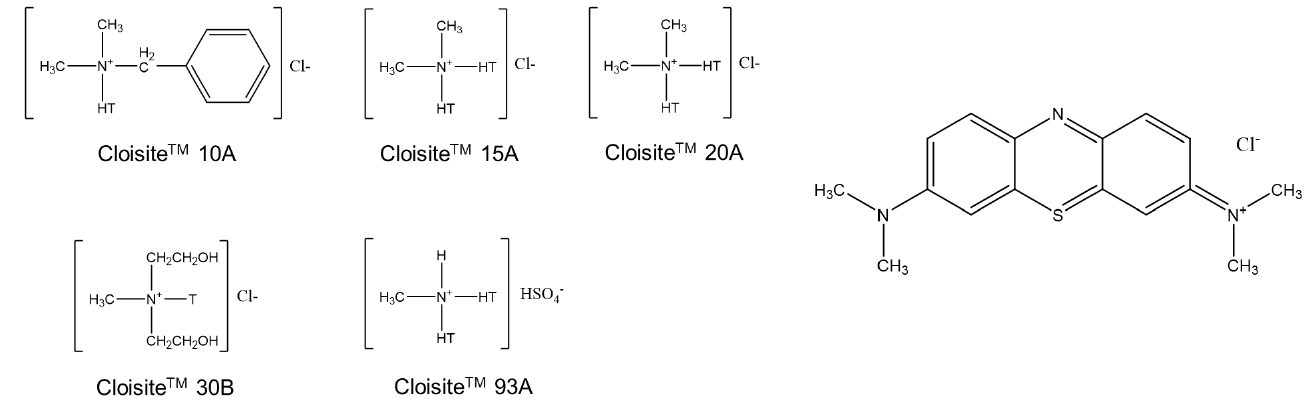
Figure A1. Respective organic modifiers of clays ( left ), and MB organic structure ( right ).